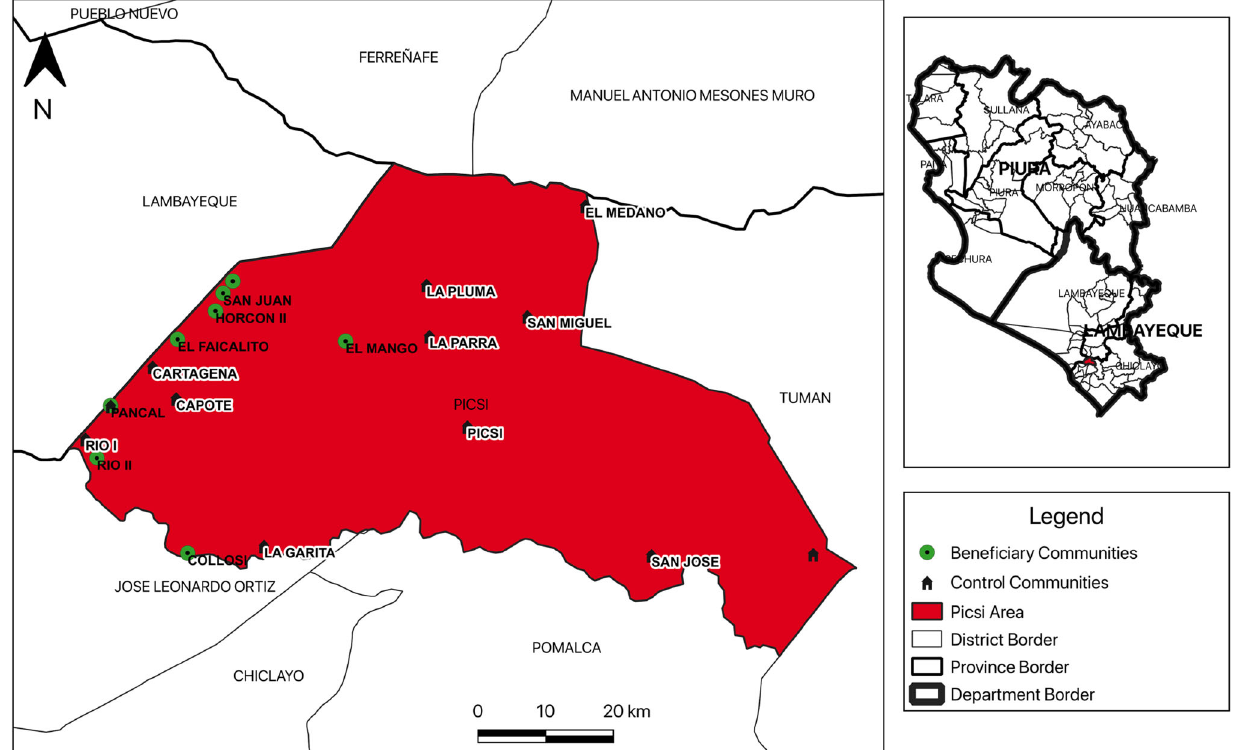
Fig. 1 Beneficiary communities in the Picsi District, Chiclayo Province, Lambayeque Region. Source FbF